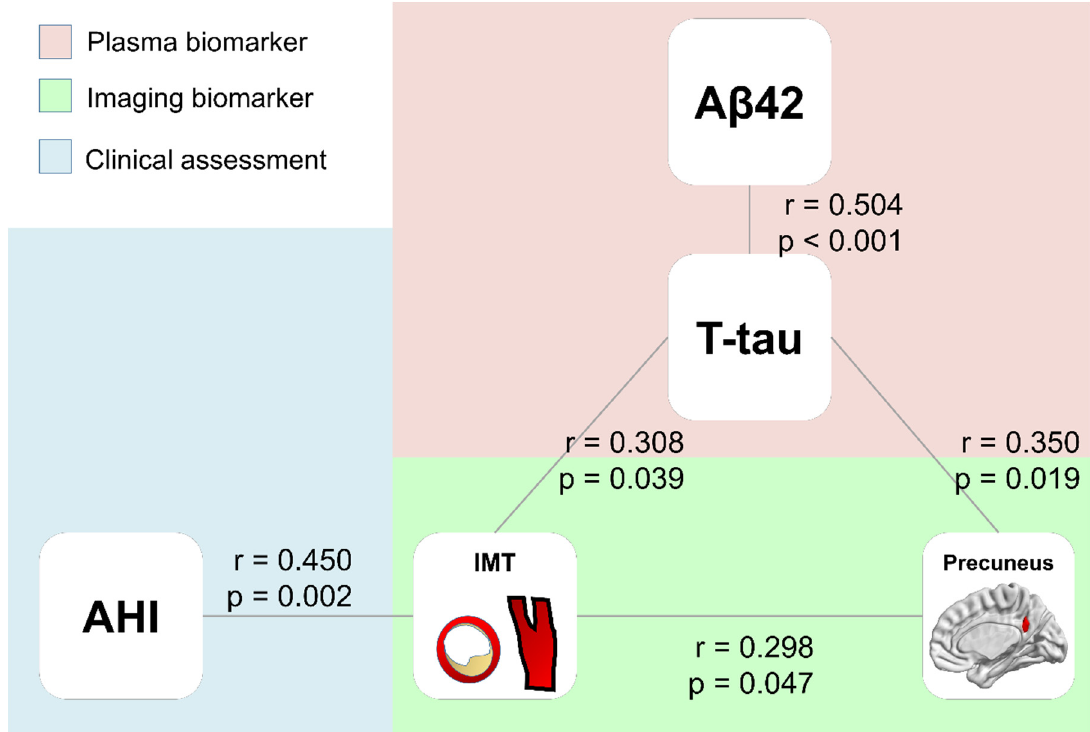
Figure 3. Correlations among plasma AD biomarkers, IMT, and GMV of the right precuneus. The T-tau plasma level is correlated with plasma levels of A β 42, IMT of CCA, and GMV of the right precuneus. The IMT of CCA is correlated with GMV of the right precuneus and AHI.